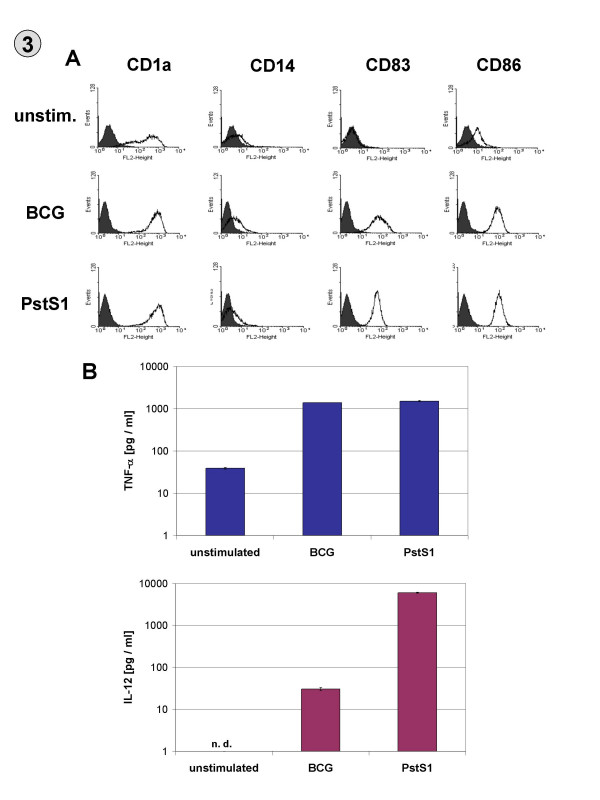
Activation of human monocyte-derived dendritic cells by PstS1. A Monocytes were differentiated for seven days with GM-CSF and IL-4 (500 U / ml each), stimulated with BCG (MOI = 0.01) or PstS1 (10 μg / ml) for three days and afterwards analyzed by flow cytometry for the expression of CD1a, CD14, CD83 and CD86. Isotype control = filled histograms, specific antibody = open histograms. Cells were gated on intact dendritic cells according to forward scatter and sideward scatter. B Supernatants of the stimulated DCs were collected and ELISAs for TNF-α and IL-12p70 were performed. One representative experiment out of 5 is shown (mean ± SD). n.d. = not detectable.